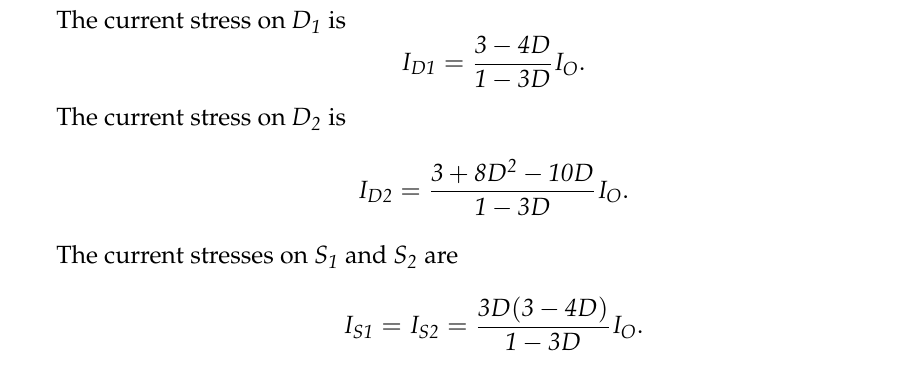
Table 1 list the voltage and current stress on each component. Table 1. Current and voltage parameters of the